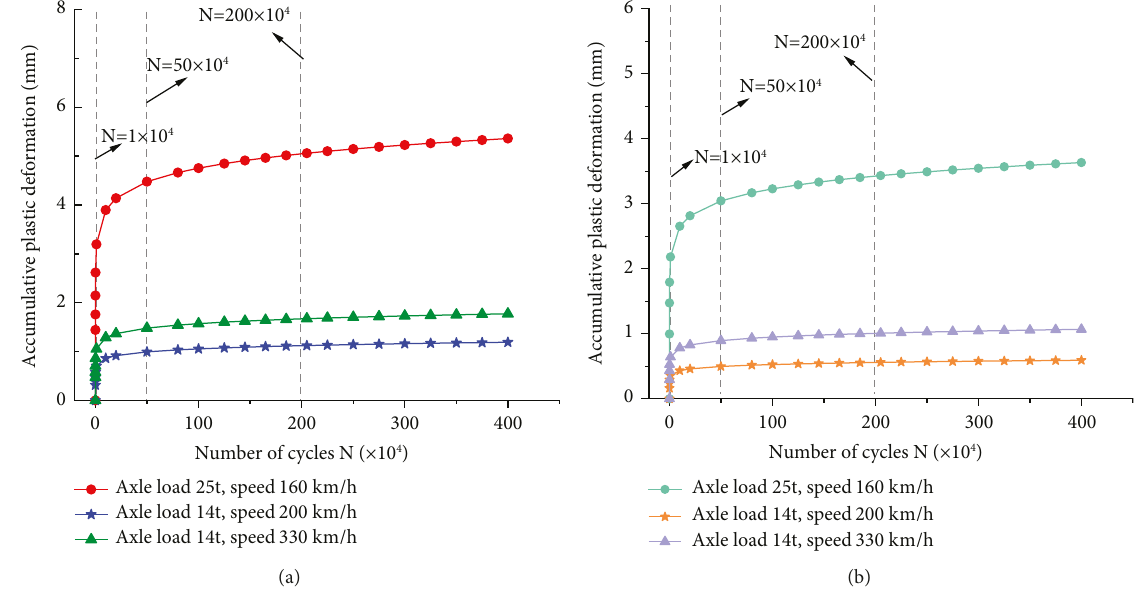
Figure 16: Calculated accumulative plastic deformation under real driving conditions. (a) Total accumulative plastic deformation below the top layer of subgrade. (b) Accumulative plastic deformation within the bottom layer of subgrade